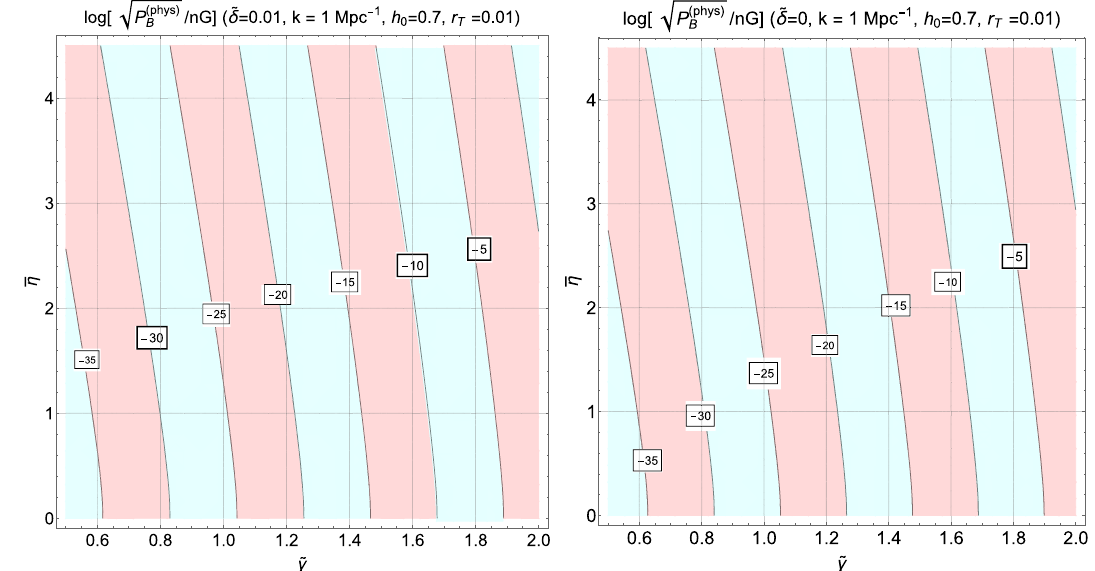
Fig. 6 The parameter space is illustrated in the ( (cid:8) γ, η) plane. As in Fig. 3 the numbers appearing on the various contours correspond to the common (cid:21) logarithm of